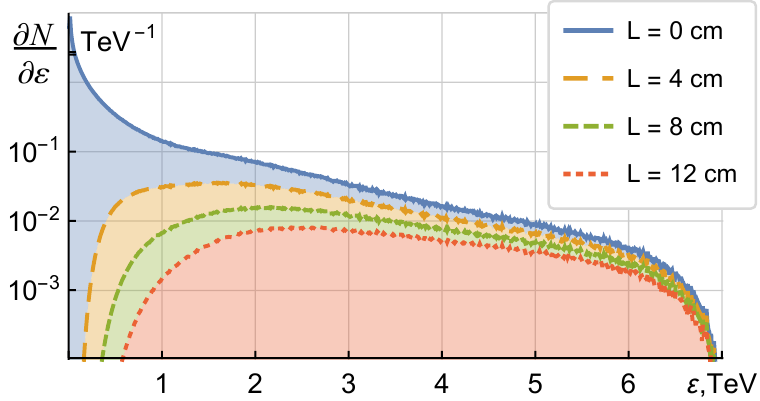
Figure 3 . Energy distribution of (cid:3) + baryons produced by 7 TeV protons in p - N collision in a c (cid:12)xed target normalized to one produced (cid:3) + baryon. Solid blue curve is for the initial distribution c ( L = 0), dashed curves are for di(cid:11)erent distances from the production point (listed on the